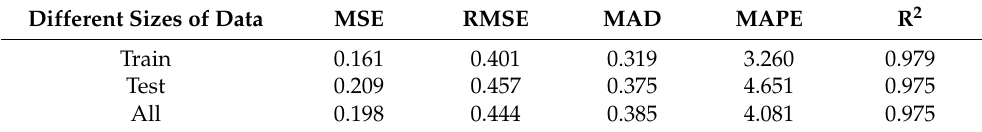
Table 3. The statistical analysis results of using different sizes of data.